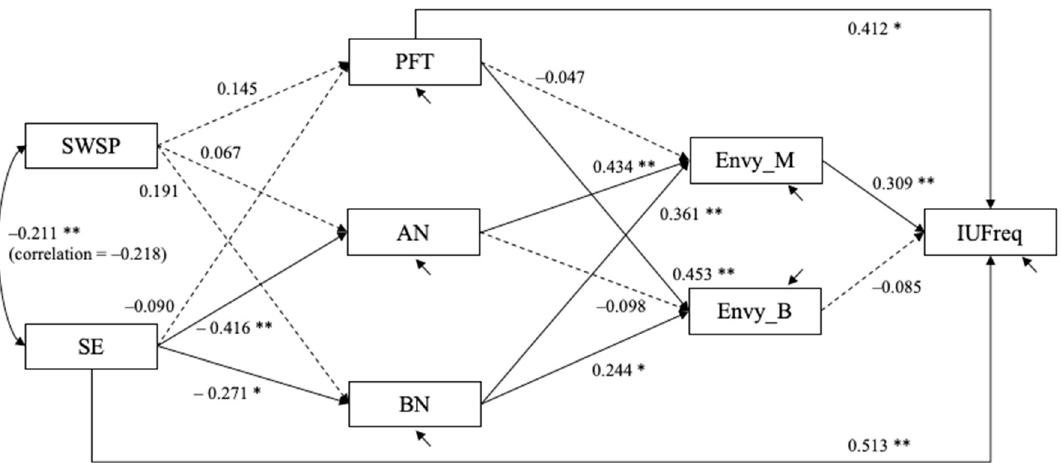
Figure 6. Study 2: Estimated structural equation model with objective measure of Instagram usage (N = 140).